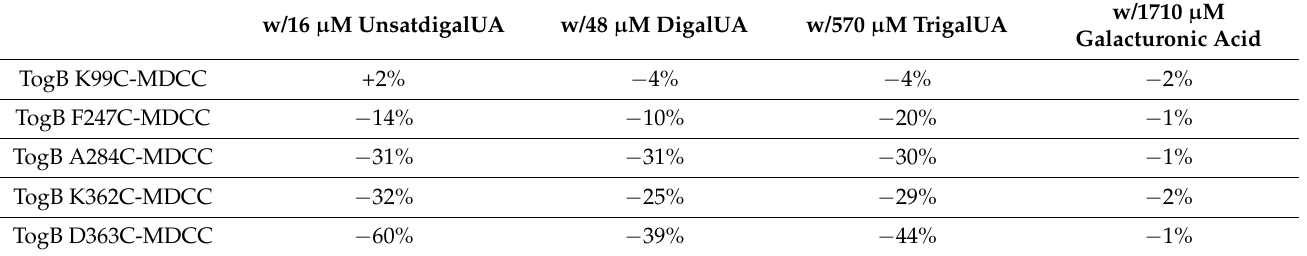
Table 1. Response of fluorescently labeled TogB variants to ligand. Fluorescently labeled TogB variants were incubated in the absence and presence of saturating concentrations of unsatdigalUA, digalUA, and trigalUA (saturating concentrations defined as ligand concentration at least three-fold above previously reported dissociation constants [26]). Labeled TogB variants were also incubated in the absence and presence of a non-specific carbohydrate galacturonic acid. Values reported indicate percentage change in peak fluorescence intensity after addition of ligand (n = 1). w/1710 µ w/16 µ M UnsatdigalUA w/48 µ M DigalUA w/570 µ M TrigalUA